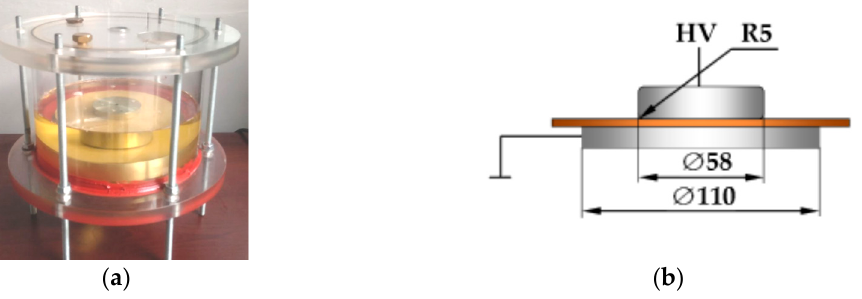
Figure 3. ( a ) Photograph of the test chamber; ( b ) Copper electrodes dimensions.